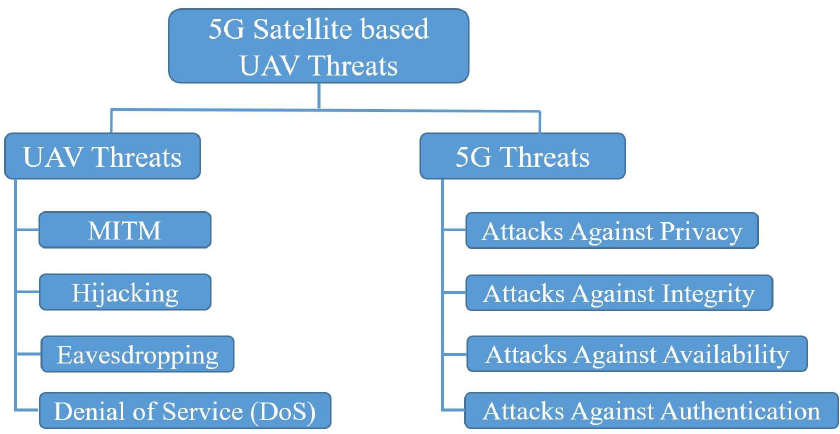
Figure 8. Threats in the 5G and UAV